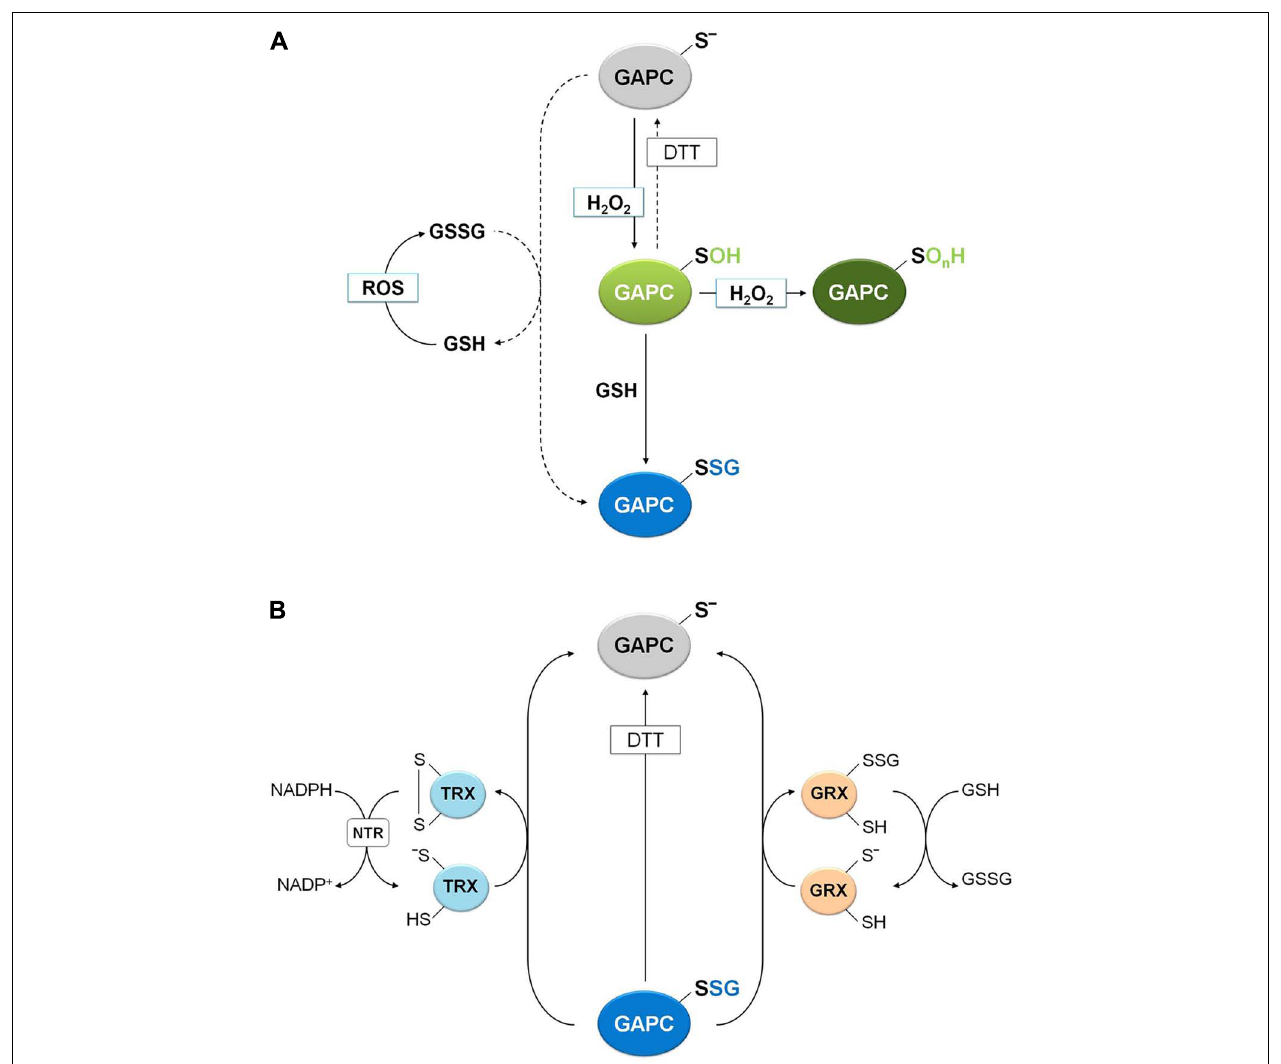
FIGURE 5 | Molecular mechanisms of plant GAPC glutathionylation and deglutathionylation. (A) Oxidation and glutathionylation of plant GAPC. Plant GAPC can undergo primary oxidation to sulfenic acid (GAPC-SOH) in the presence of H 2 O 2 that can subsequently react with GSH leading to the glutathionylated form (GAPC-SSG) and protecting the enzyme from irreversible oxidation (GAPC-SO n H). In principle, GAPC glutathionylation may also be performed by GSSG with release of GSH, but this reaction does not occur under physiological GSH/GSSG ratios (dashed arrow). GSSG can be formed by the reaction of GSH with